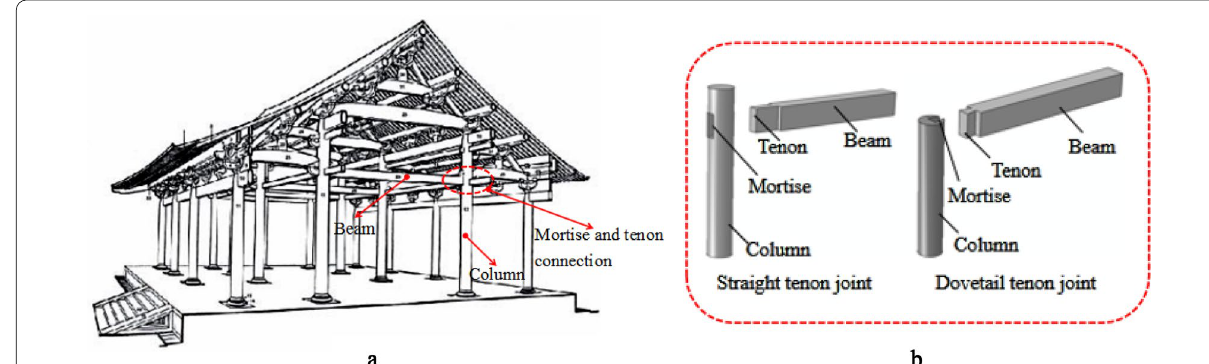
Fig. 1 Typical M&T connections: a typical ancient timber structure; b M&T joints